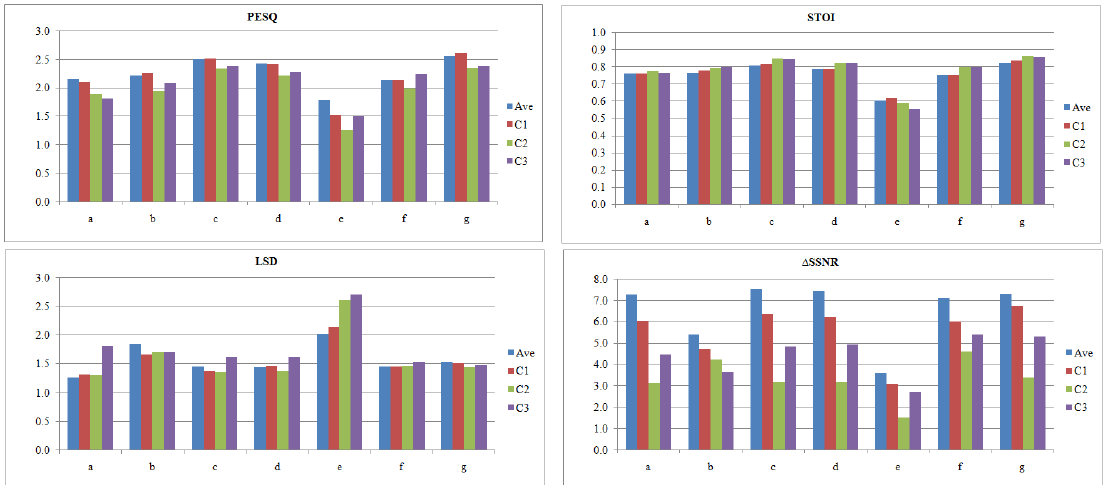
Figure 7. PESQ, STOI, LSD, and ∆ SSNR results for the processed unseen noisy speech from the same training dataset, C1; from unseen dataset, C2; and, speech from 90 different languages, C3, as compared to the average results shown in Table 3,